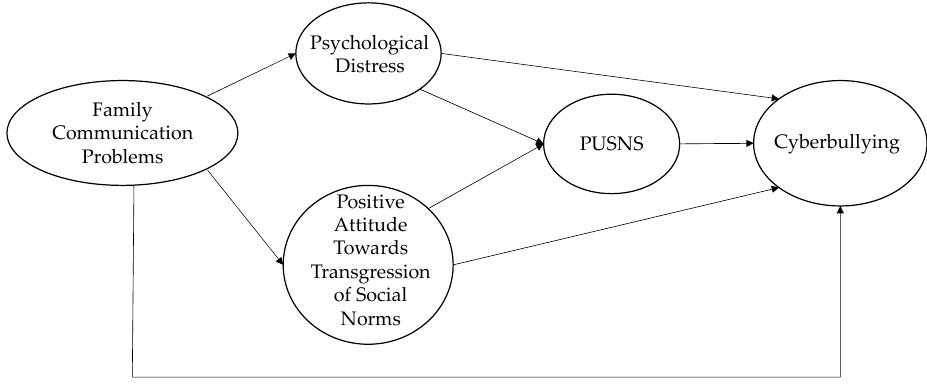
Figure 1. Theoretical model proposed.